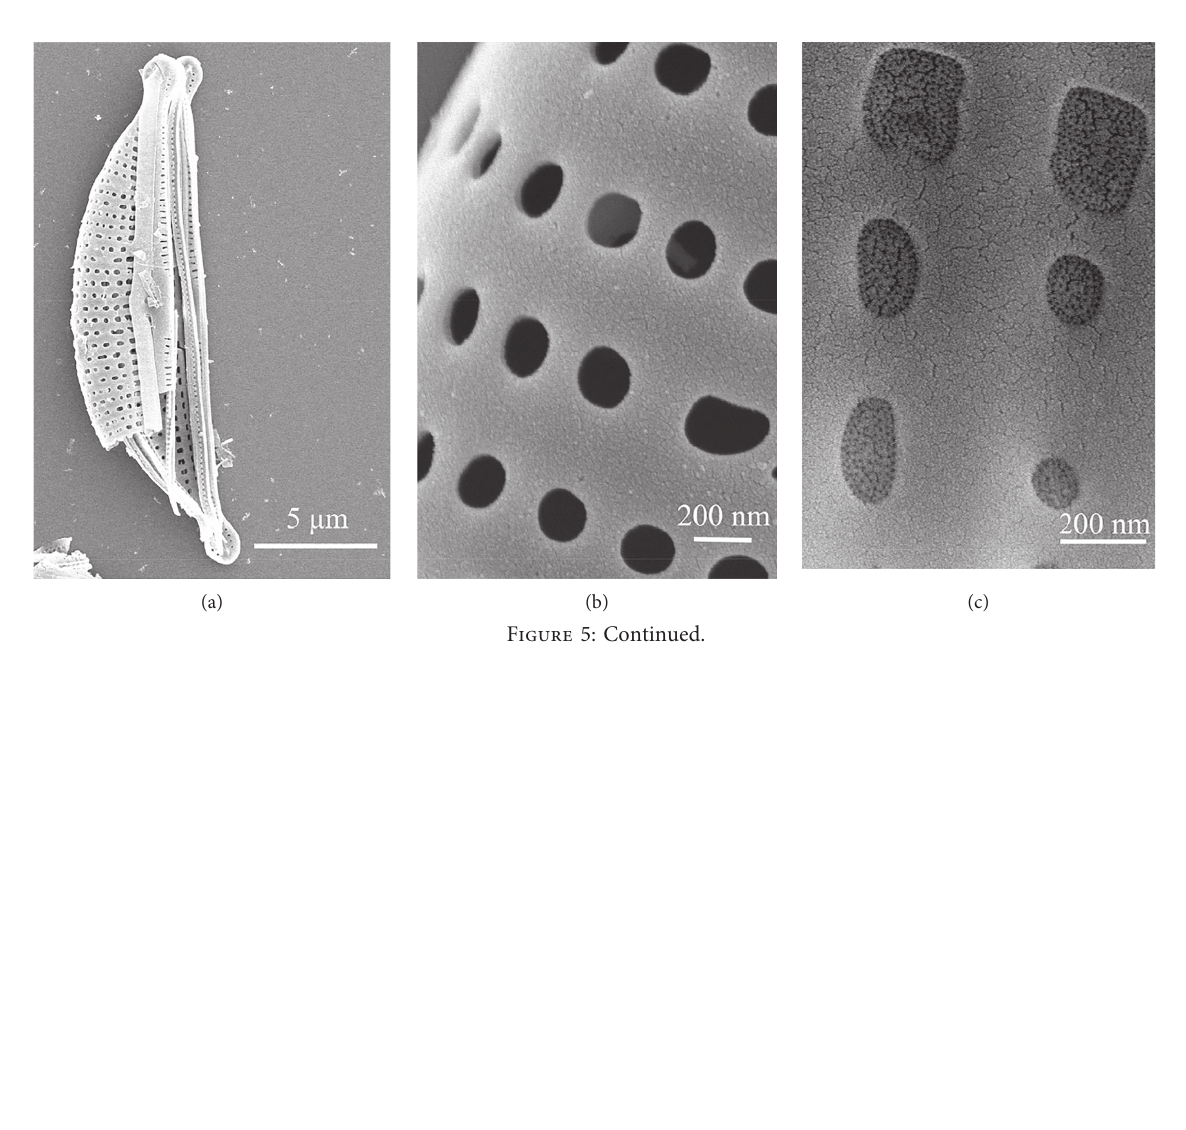
2 film, and (c) on diatom frustule-TiO 2 (TF3)